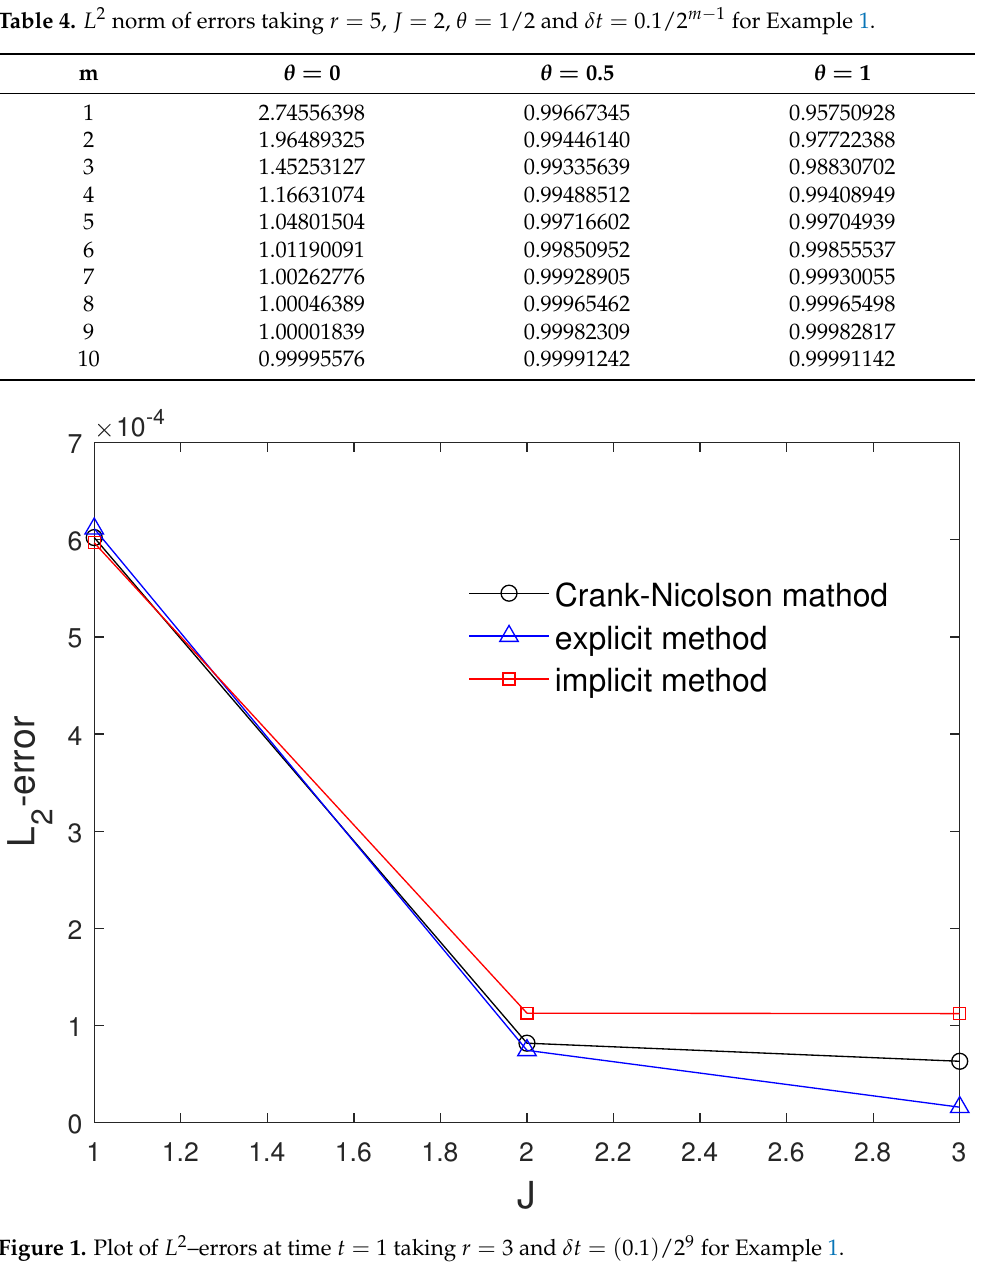
Figure 1. Plot of L 2 –errors at time t = 1 taking r = 3 and δ t = ( 0.1 ) /2 9 for Example